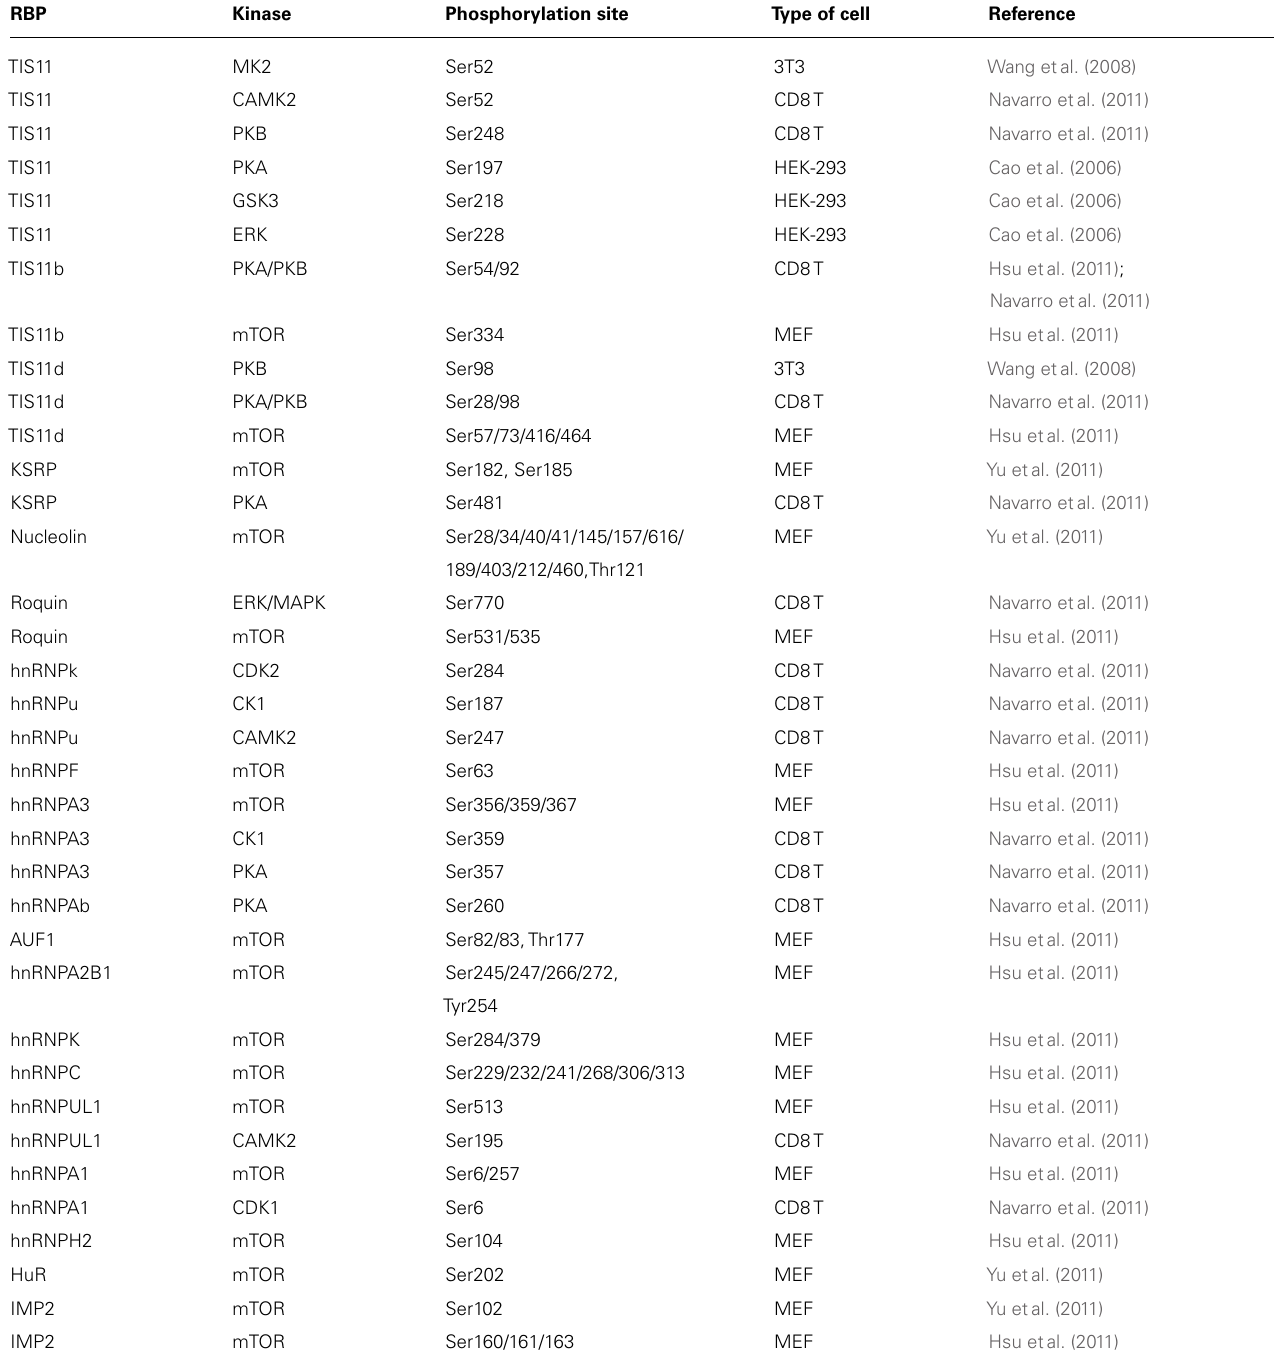
The phosphorylation sites on RBPs for respective kinases in a specific cell are obtained from published phospho-proteomic studies. In Yu etal. (2011)), mTOR phosphorylation sites on RBP in MEFs are derived using inhibitors rapamycin and KU-0063794 against mTOR in a SILAC experiment. Similarly in Hsu etal. (2011), mTOR regulated phosphosites on RBPs in MEFs were verified usingTorin1 (mTOR) inhibitor in an iTRAQ experiment. By employing SILAC technology, Navarro etal. (2011) identified phosphorylation sites on different RBPs for the respective kinases inTCR stimulated CD8T cells.Wang etal. (2008) identified phosphorylation sites on RBPs in 3T3 cells using